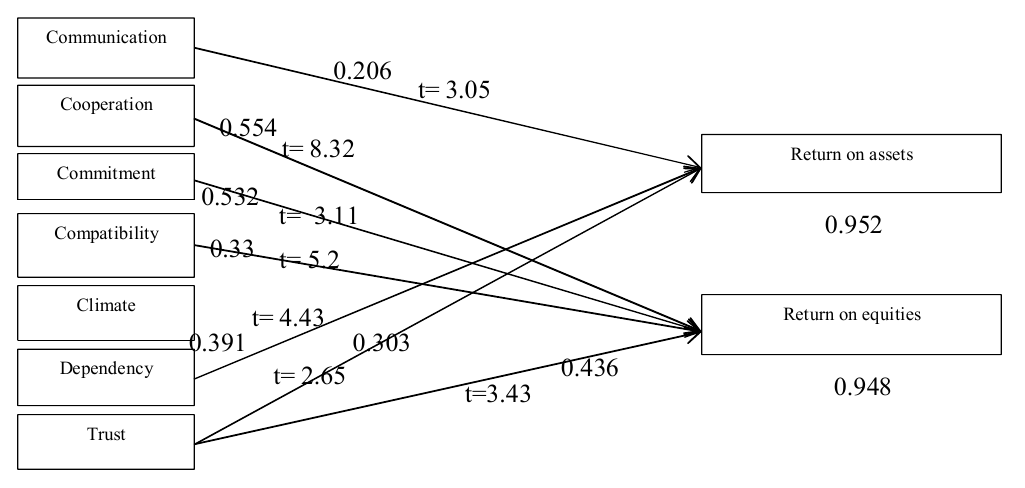
Fig. 1. The result of the implementation of structural equation